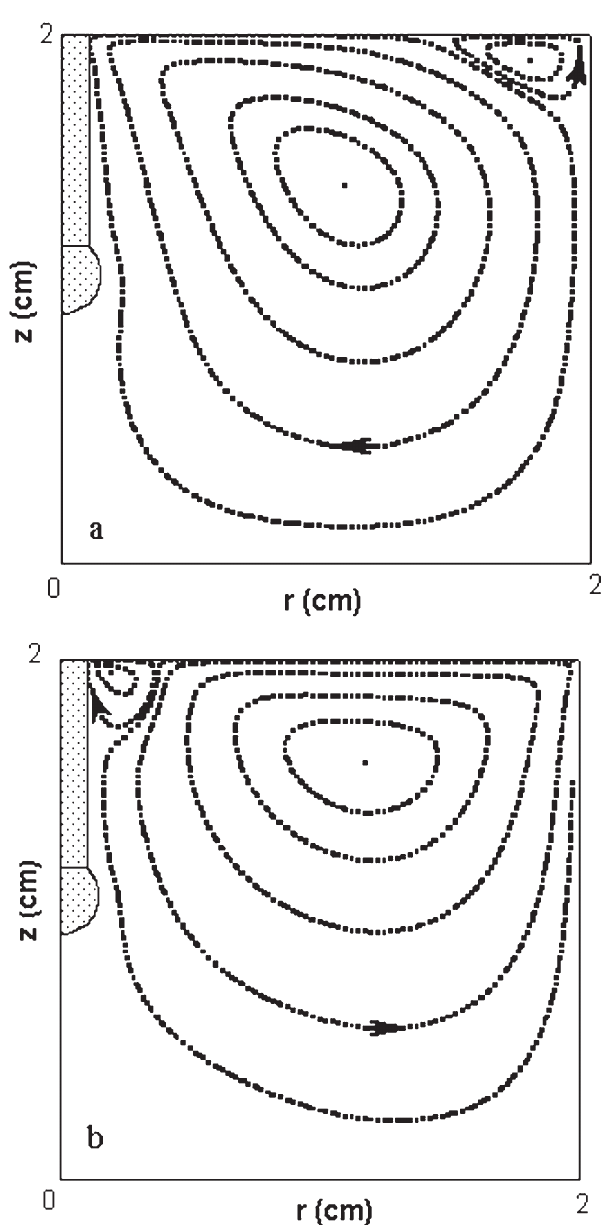
Figure 13. The reverse convective roll causing the return to the slow diffusion stage in oscillatory regime (numerical results, reprinted from [44], with permission from American Physical Society, see text for